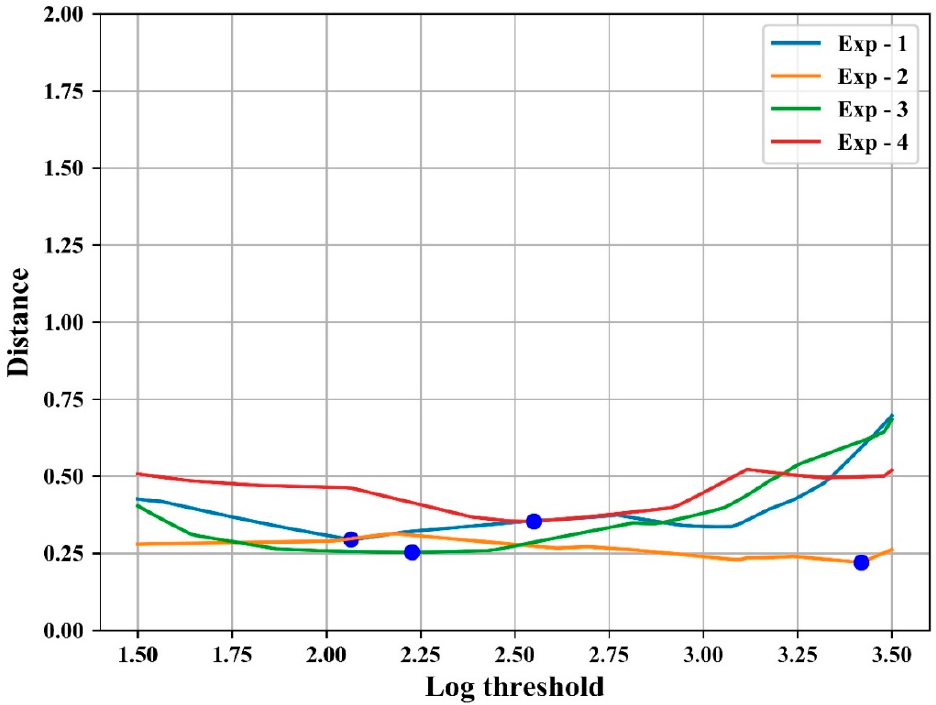
Figure 8. Distance according to log threshold for each experiment in set A. Table 1. Distances of C t values according to the threshold of each experiment.